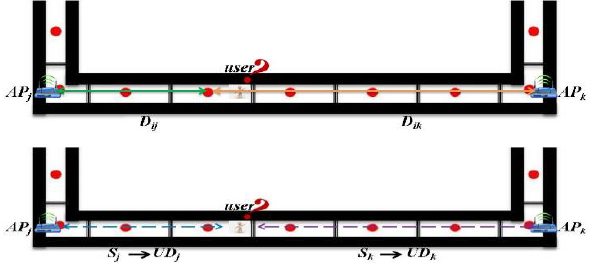
Figure 4. Considering the physical distance between a person and AP (denoted as D ) to the WiFi distance and AP (denoted as UD ).